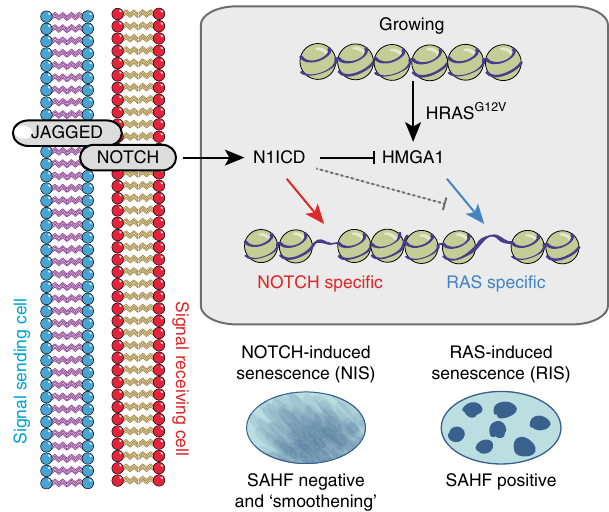
Fig. 8 NOTCH1 signalling mediates non-cell autonomous regulation of chromatin structure at the microscopic and nucleosome scale. Lateral induction of NOTCH1 activity in a signal-receiving cell by JAG1 on the surface of an adjacent cell (including cancer cells) can drive NIS. NIS cells form unique chromatin-accessible regions and microscopically ‘ smoothened ’ chromatin. In the context of RIS, non-cell autonomous activation of NOTCH1 signalling can repress the formation of AT-rich RAS- driven accessible regions at the nucleosome level and SAHF formation at the microscopic level. Mechanistically, N1ICD represses HMGA1, which is ectopic-accessible chromatin in RIS